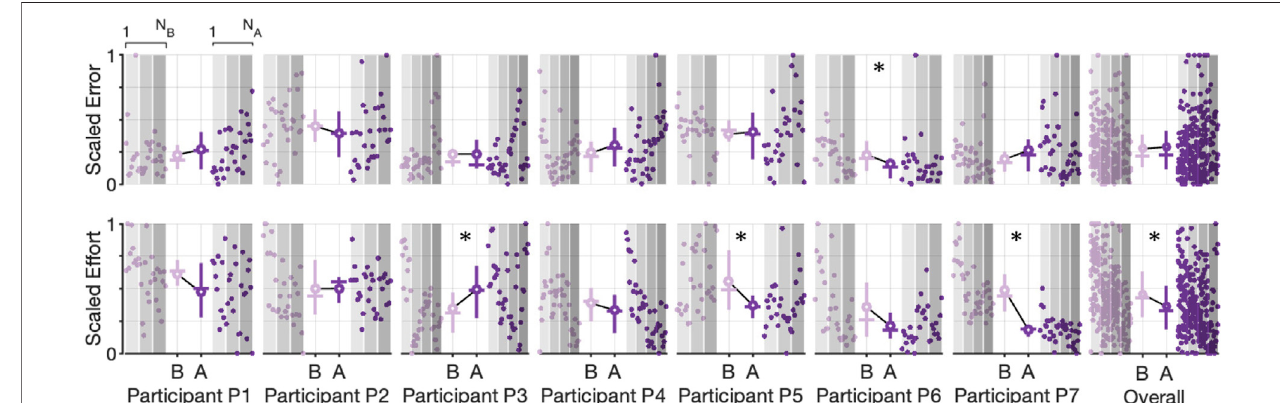
FIGURE 9 | Scatter plots and corresponding interquartile range (Q3-Q1) shown as vertical lines, mean value (solid circle), median value (horizontal line), and trend lineforscalederrorandscaled effortforeachcycleduring theStiffness-Dominatecondition.Observations areplottedinorder(1to N B forthebaselineconditionand1to N A fortheassistance condition). Increasingshaded regionsdenote each experimental block. Asterisksdenote asigni fi cant( p ≤ 0 . 05)test decisionforthenull hypothesis that the data from both conditions are from the same distribution using a two-sample Kolmogorov – Smirnov test.